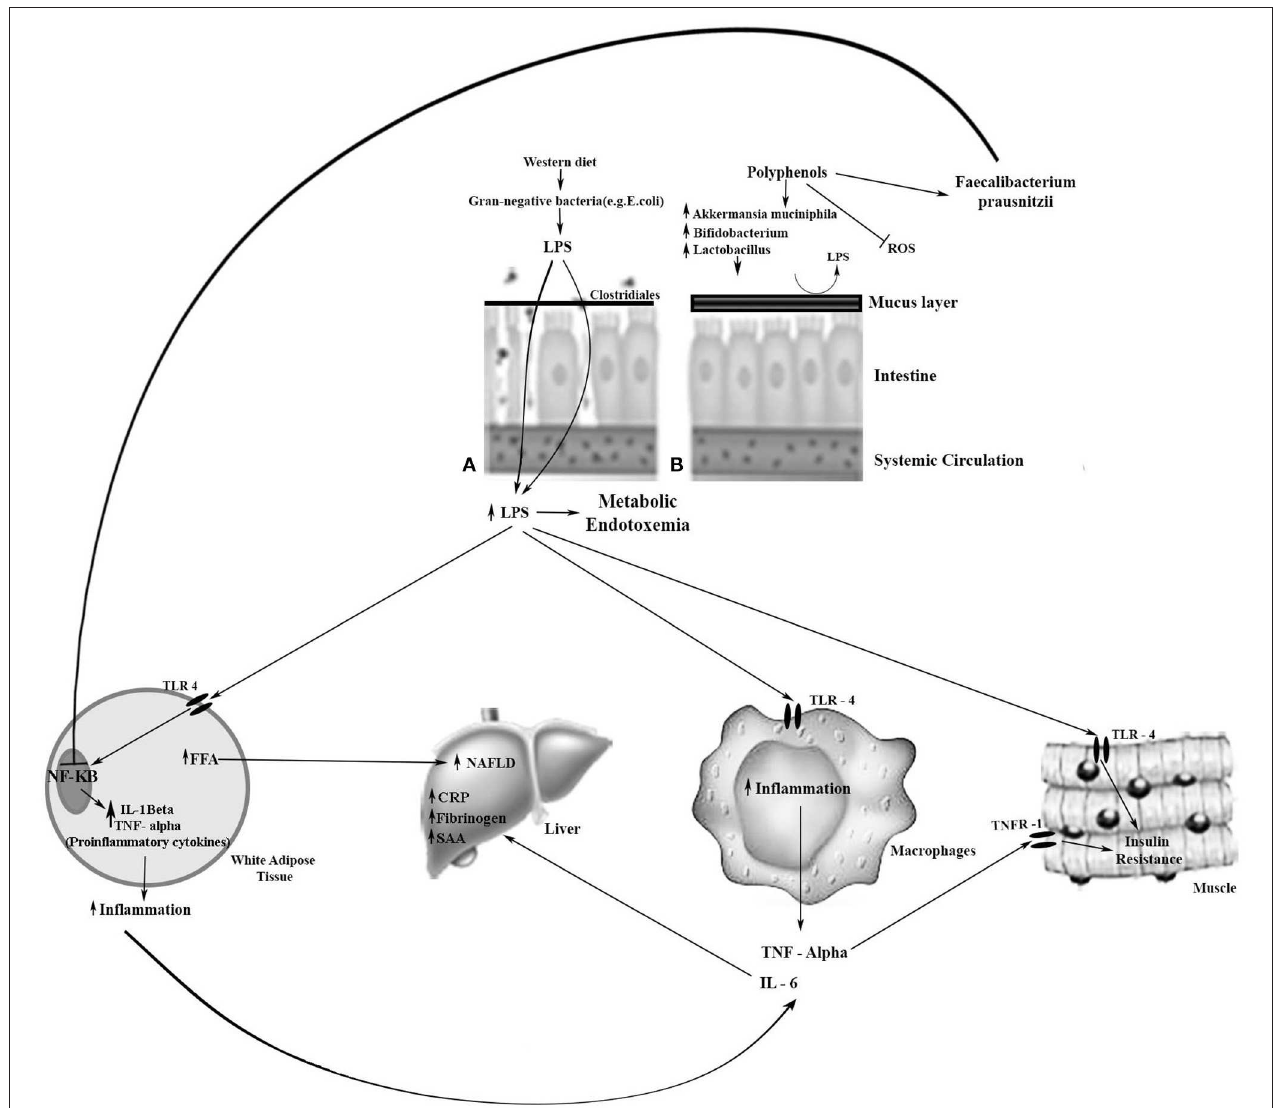
FIGURE 1 | Metabolic effects of LPS and the effect of polyphenols on beneficial bacteria on enterocytes. (A) Leaky and inflamed gut. A Western diet, rich in simple carbohydrates (sugar), saturated fatty acids, and low in dietetic fiber, may cause obesity-related dysbiosis, and, consequently, loss of gut barrier integrity. The reduction of mucosal layer thickness and increase in the gut barrier permeability favors the LPS pass through the intestinal cells to the bloodstream, resulting in metabolic endotoxemia. LPS is transported to the target tissues by chylomicrons. LPS binds to TLR-4 in the target tissue and triggers an inflammatory response. (B) Normal gut. Dietary polyphenols may sequester reactive oxygen species (ROS); increase Bifidobacterium spp., Lactobacillus spp., and Akkermansia muciniphila which are associated with the preservation of the integrity of the intestinal mucus layer and intestinal barrier function; and increase Faecalibacterium prausnitzii which inhibits the NF-kB activation. Thereby, there is a reduction in lipid storage, insulin resistance, and inflammation. → , Activation; ⊣ , Inhibition; CRP, C-reactive protein; FFA, free fatty acids; IL, Interleukin; LPS, lipopolysaccharide; NAFLD, non-alcoholic fatty liver disease; NF-kB, nuclear factor-kappa B; SAA, serum amyloid A; TLR-4,